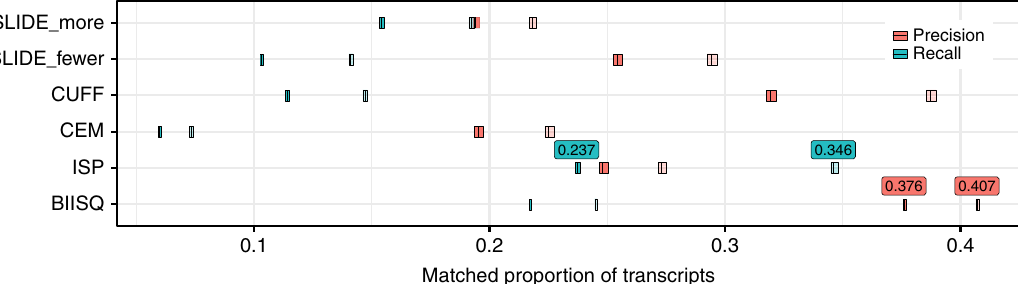
Fig. 2 Isoform discovery precision and recall for simulated data. Precision (red) and recall (blue) of the results from BIISQ , ISP, CEM, Cuf fl inks (CUFF), and SLIDE (SLIDE_more and SLIDE_fewer) applied to the BEERS-simulated single-end RNA-seq data. The thick center bars denote the mean precision or recall and the fi ll denotes three times the standard error. Transparent fi ll denotes partial precision and recall with a matching threshold of 0.1. Across all methods, the best (partial) precision and recall values are annotated above their respective data points